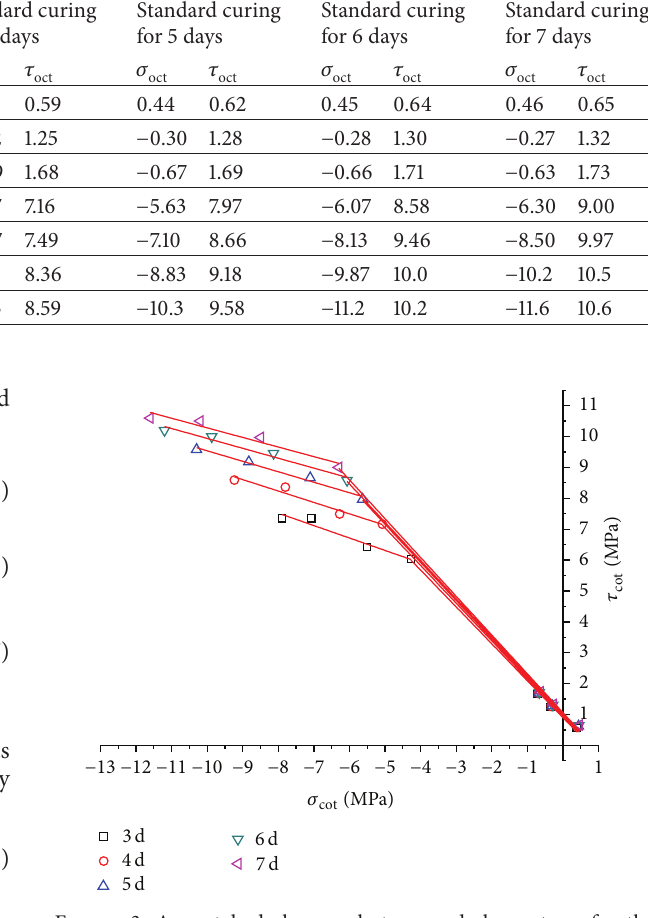
Figure 3: An octahedral normal stress and shear stress for the ultimate strength of C20-concrete at an early-age after standard duration of curing, that is, 3–7